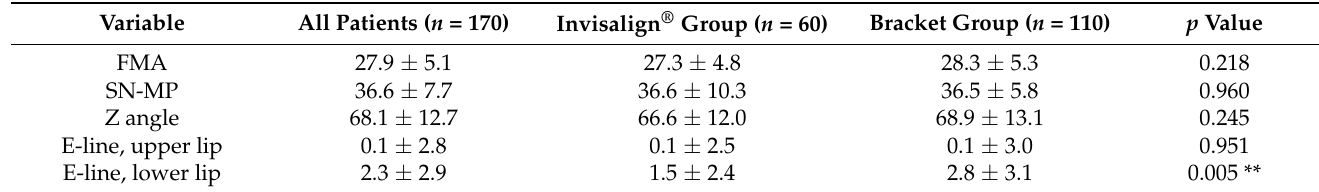
Table 5. Cephalometric facial measurements of patients, stratified by orthodontic device (Invisalign ® or bracket) ( n = 170).